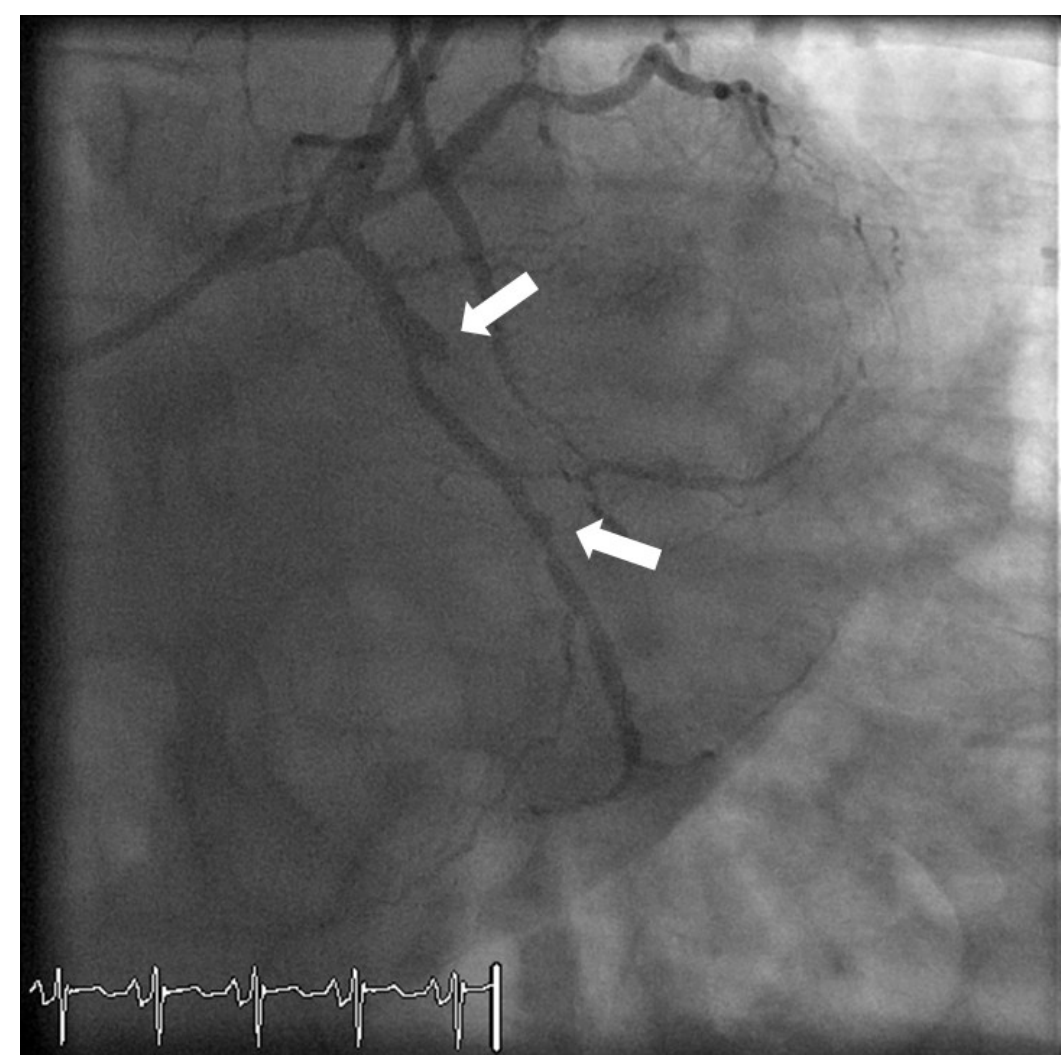
Figure 13. Coronary angiogram demonstrating occluded OM1 and OM2